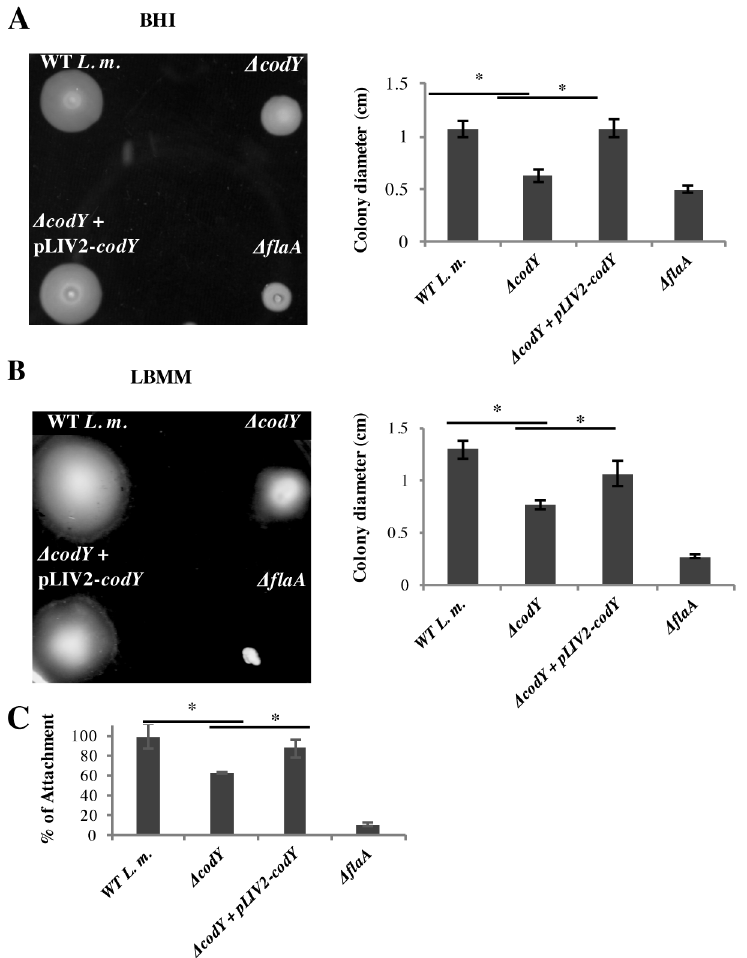
Fig 6. Δ codY mutant is impaired in motility and cell adhesion. Swarming of L . monocytogenes WT and Δ codY bacteria, as well a codY complemented strain on BHI A. and LBMM B. soft agar plates. Δ flaA strain was used as a negative control. Results are representative of at least 3 biological repeats. Bar charts represent the diameters of bacterial growth zones, based on 3 independent biological repeats. C. An attachment assay of WT, Δ codY and codY complemented L . monocytogenes strains to Caco2 epithelial cells. Δ flaA is used as a negative control. The results represent at least 3 biological repeats Error bars represent standard error of the mean (SE). Asterisk ( * ) represents p-value < 0.05. Student ’ s t-test was used for statistical